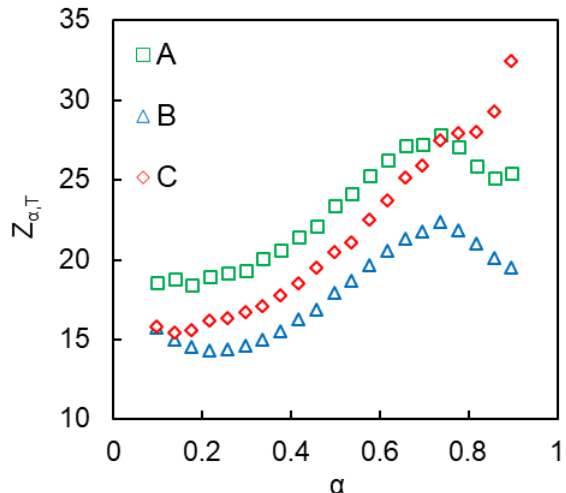
Figure16. Variation ofthe isoconversional-isothermal accelerationfactor Z α , T withconversion at250 ◦ Figure 16. Variation of the isoconversional-isothermal acceleration factor Z α , T with conversion at 250 °C.